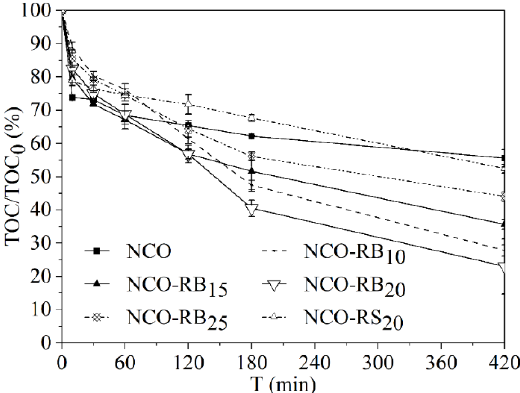
Figure 5. Variations of total organic carbon (TOC) in catalytic air oxidation of humic acid (HA) solutions using NCO, NCO-RB 10 , NCO-RB 15 , NCO-RB 20 , NCO-RB 25 , and NCO-RS 20 as the catalysts (initial TOC, i.e., TOC 0 , 123.8 mg/L; catalysts, 5 g/L; initial pH, 8.6; temperature, 25 °C).